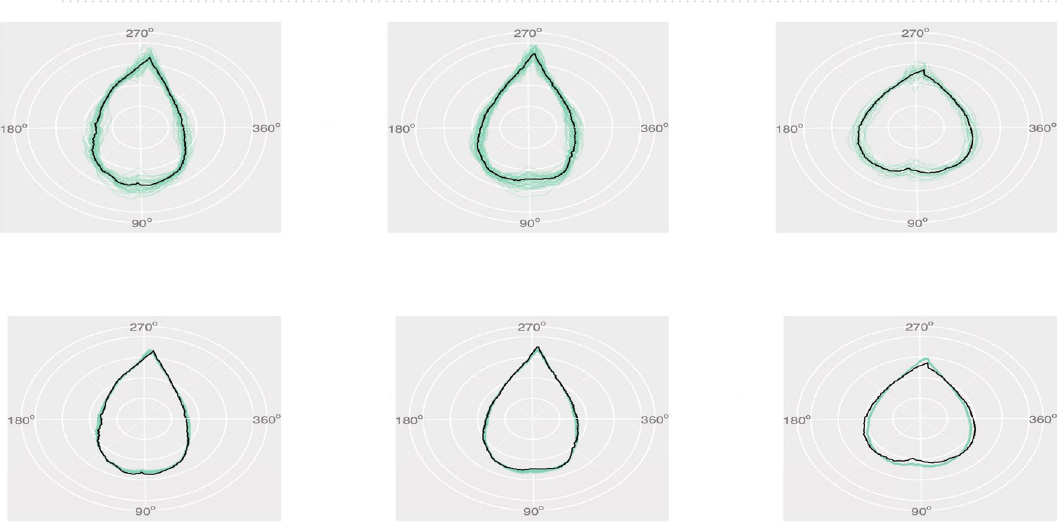
Figure 2. Same information as the Fig. 1, but converting curves into